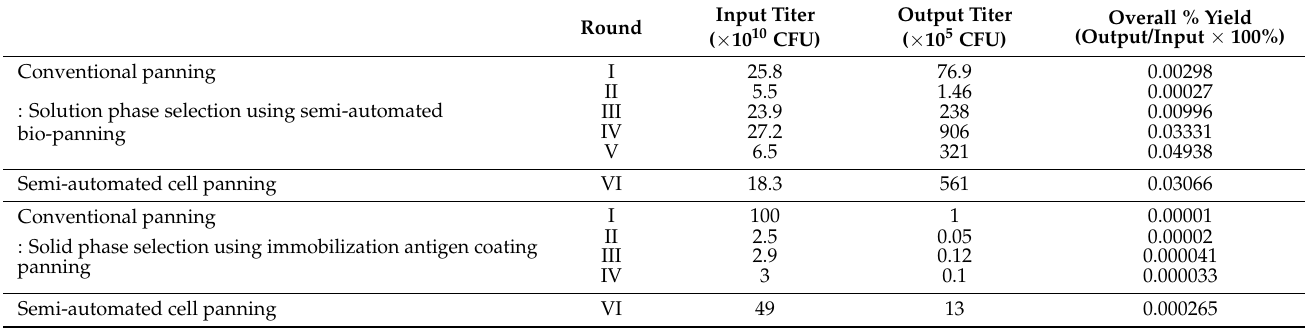
Table 1. Phage titer following conventional bio-panning and semi-automated bio-panning.